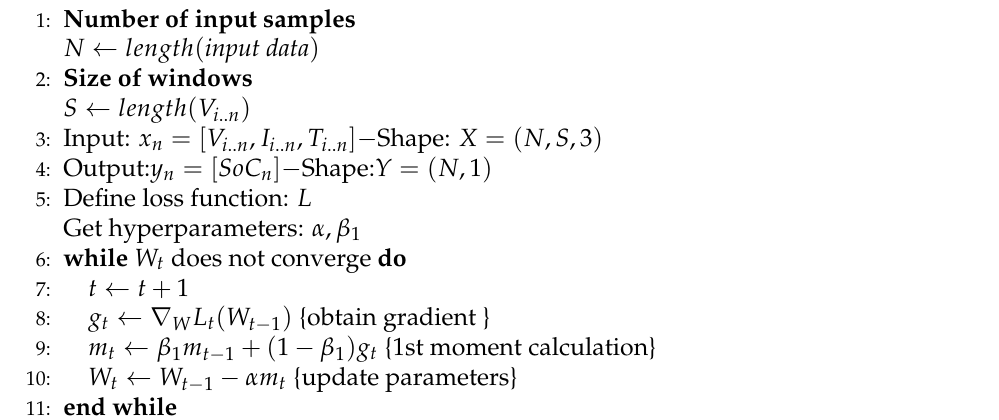
Algorithm 1 Stochastic gradient descent with momentum optimisation.